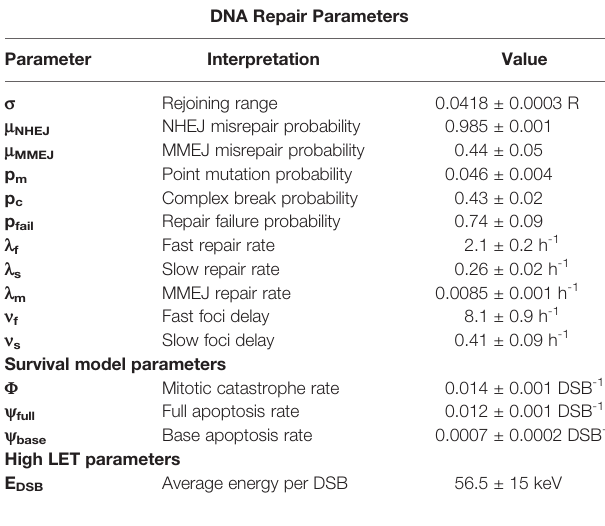
TABLE 2 | Best- fi t MEDRAS model parameters with